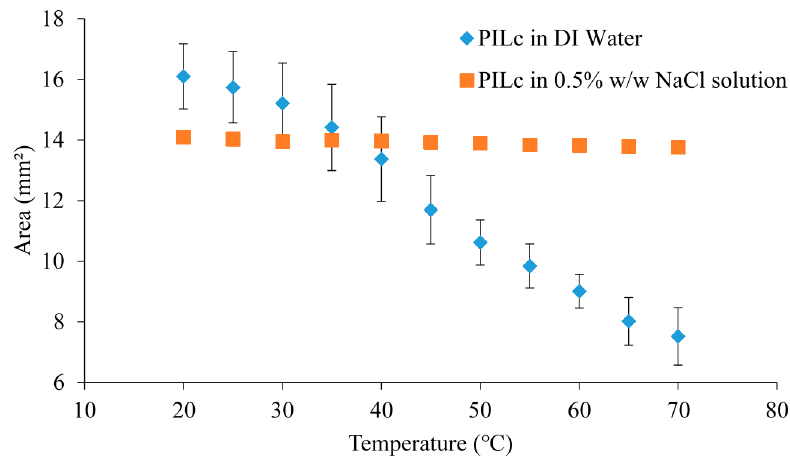
Figure 12. The shrinking profile of the PILc hydrogel in DI water and 0.5% w/w NaCl solution.